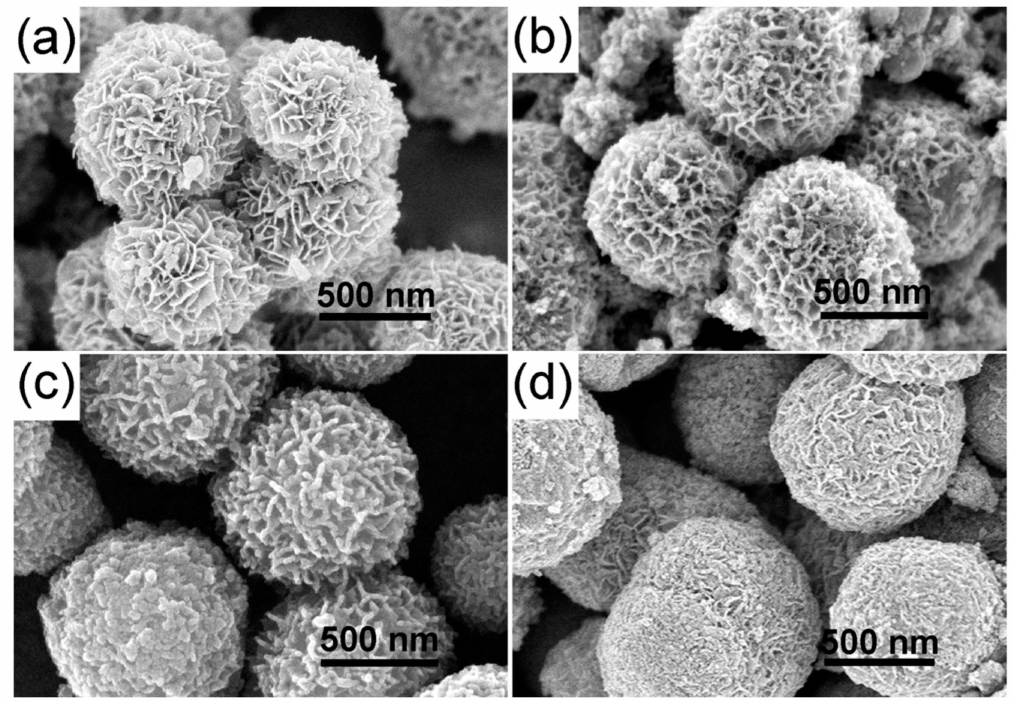
Figure 6. The FESEM images of the STO hierarchical nanospheres with di ff erent molar ratios of n Sn / n Ti : ( a ) 1%, ( b ) 5%, ( c ) 10%, and ( d )